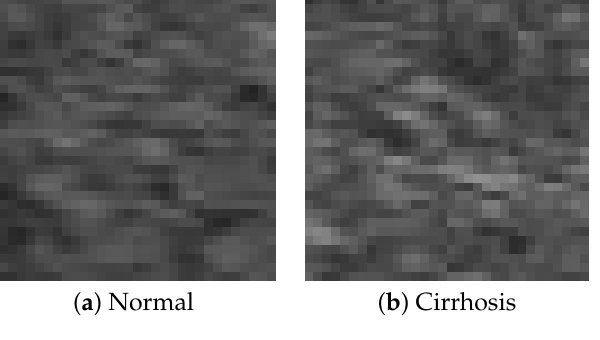
Figure 1. Liver ultrasound images.